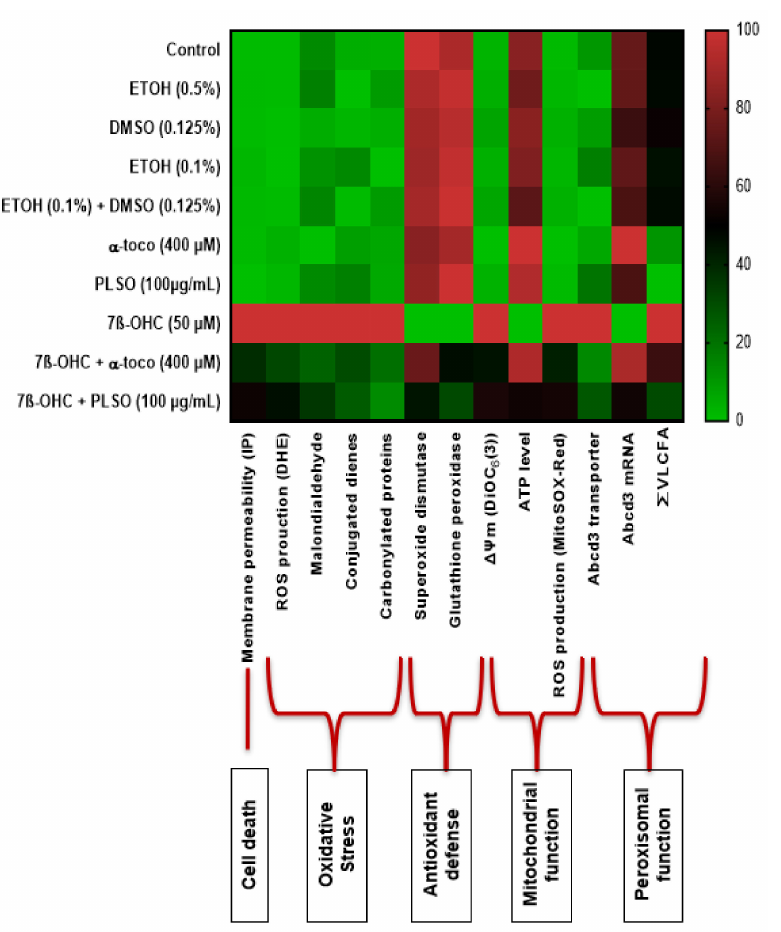
Figure 11. Heatmap representation of the toxicity of 7 β -hydroxycholesterol and of the cytoprotective effects of PLSO and α -tocopherol on C2C12 cells. Heatmap graded from green (little or no effect: 0) to red (maximum effect: